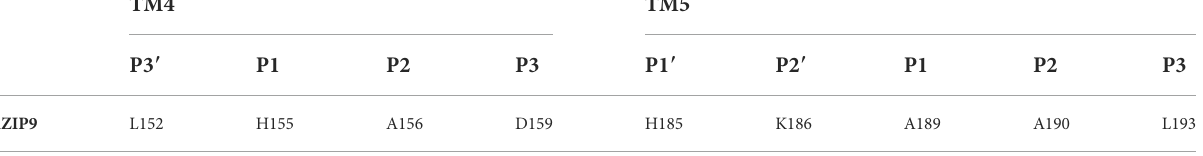
TABLE 5 Subgroup I TM4 and TM5 BMC residues.